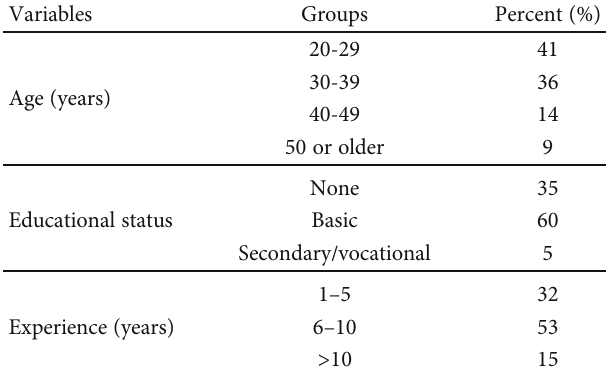
Table 1: Demographic information of